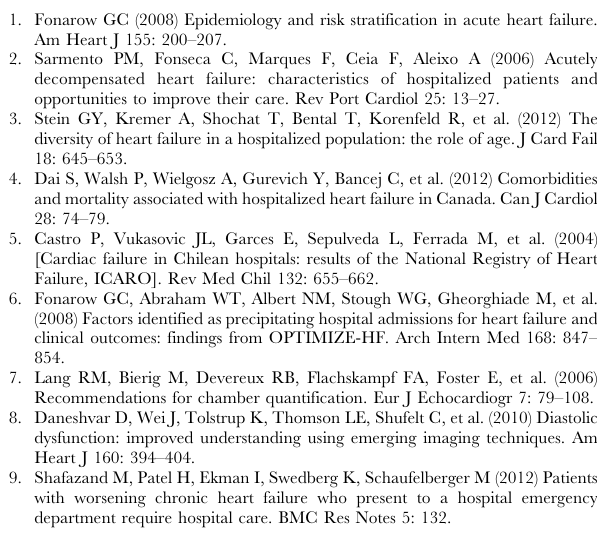
Table S1 ICD-9 codes associated with heart